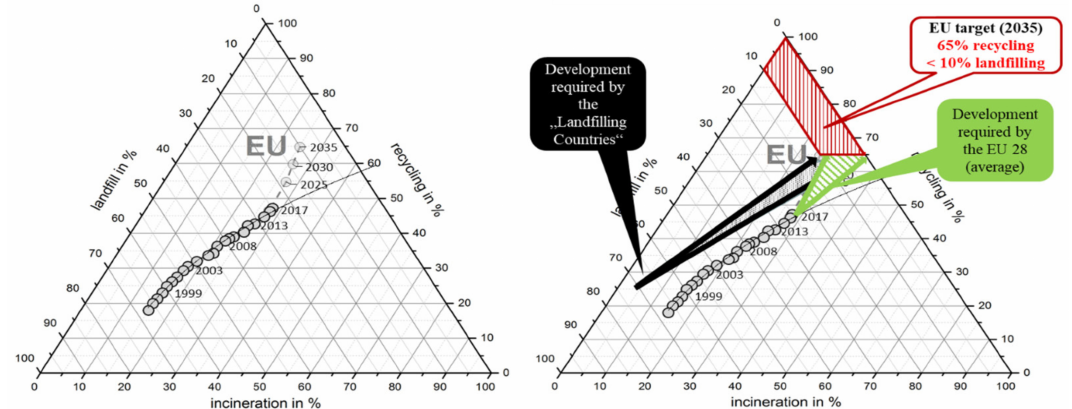
Figure 2. Left: development of municipal waste management in the EU 28 from 1995 to 2017 with the forecasts (linear extrapolation, and potential development towards the minimum requirements of the new circular economy package) until 2035. Right: required development to meet the recycling targets [5], modified from